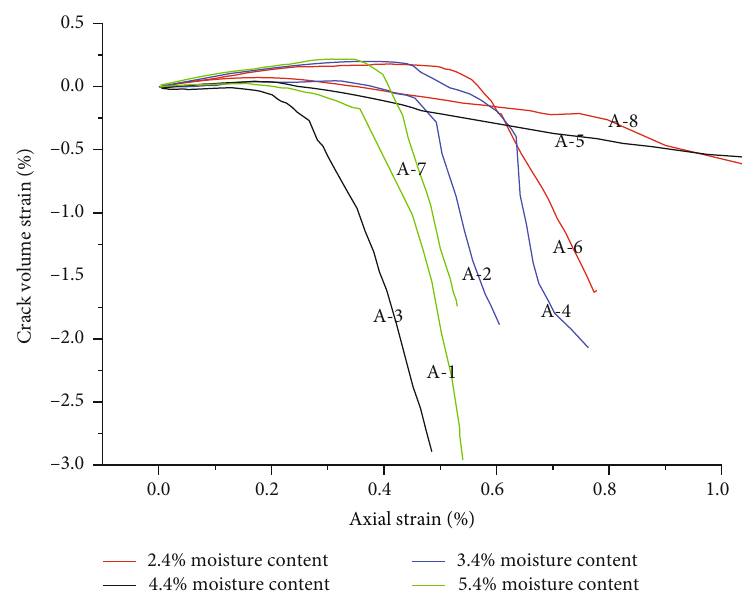
Figure 4: Volume strain-axial strain diagram of crack under di ff erent water